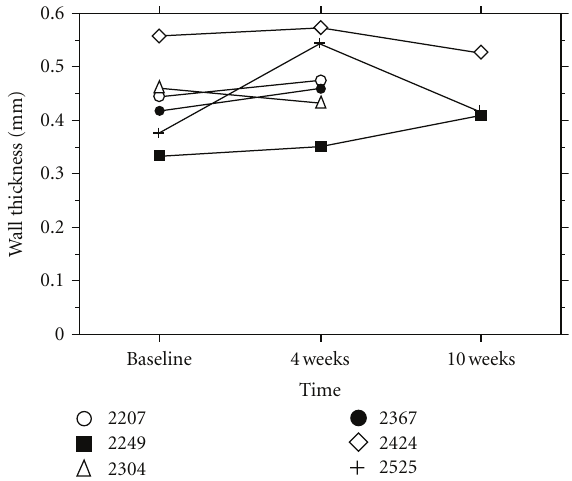
Figure 7: MRI-snakes-measured arterial wall thickness in lesion at various points in time for each individual animal, 6 slices from each region.